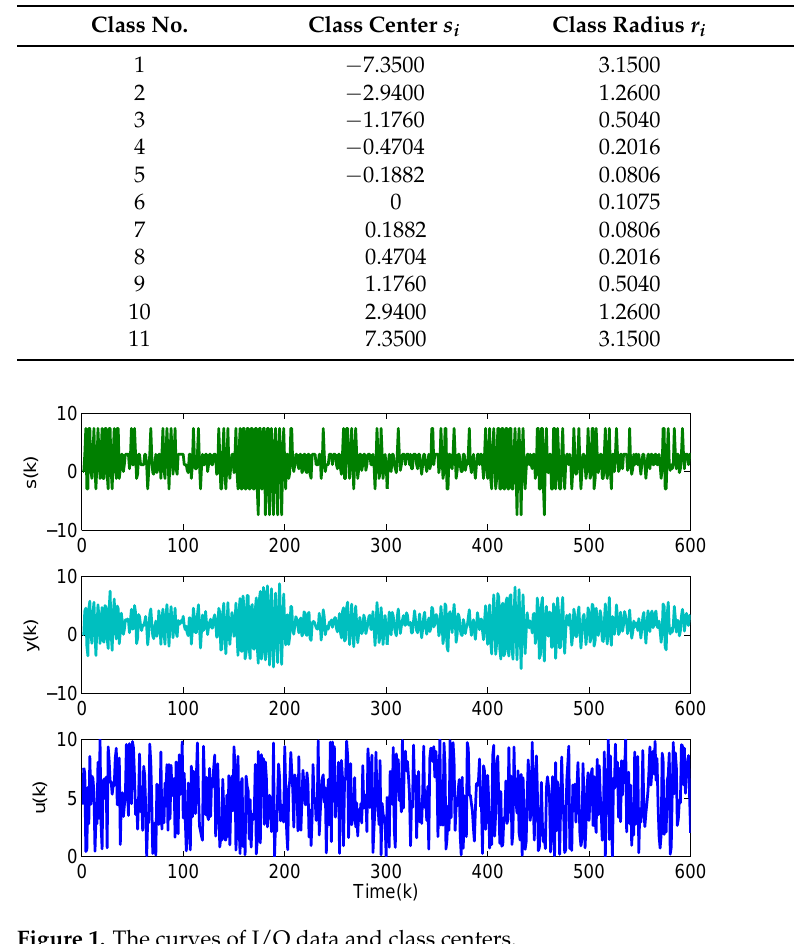
Figure 1. The curves of I/O data and class